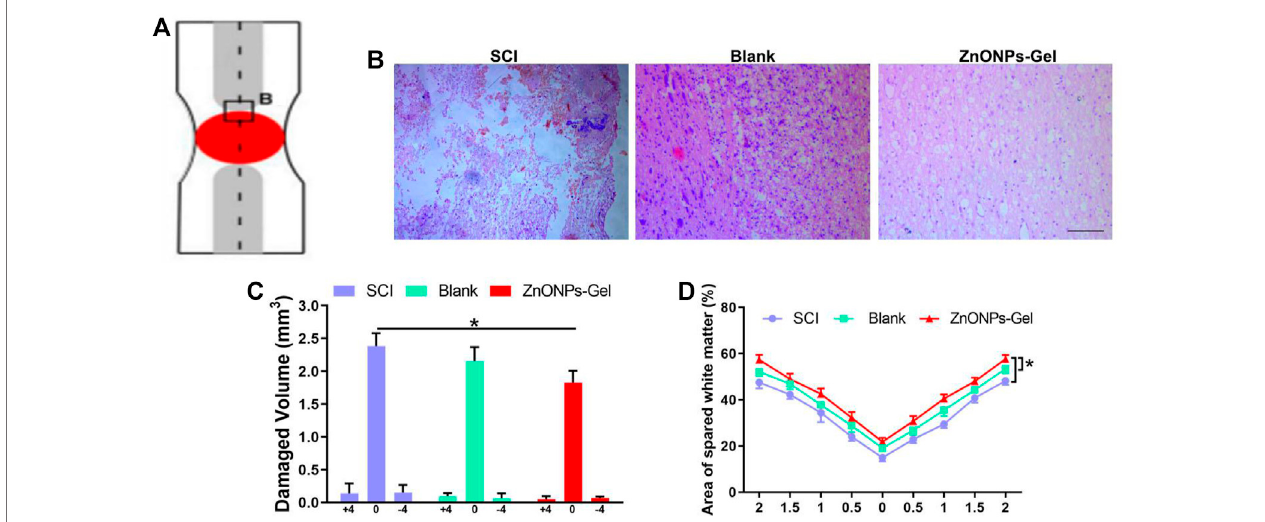
FIGURE 4 | ZnONPs-Gel promoted injured spinal cord tissue repair after SCI. Model of injured spinal cord (A) . HE staining (B) and quanti fi cation of damaged volume (C) and area of spared white matter (D) . Scale bar (cid:2) 100 μ m. Data are mean ± SD ( n (cid:2) 3); *signi fi cant difference compared to the SCI group.